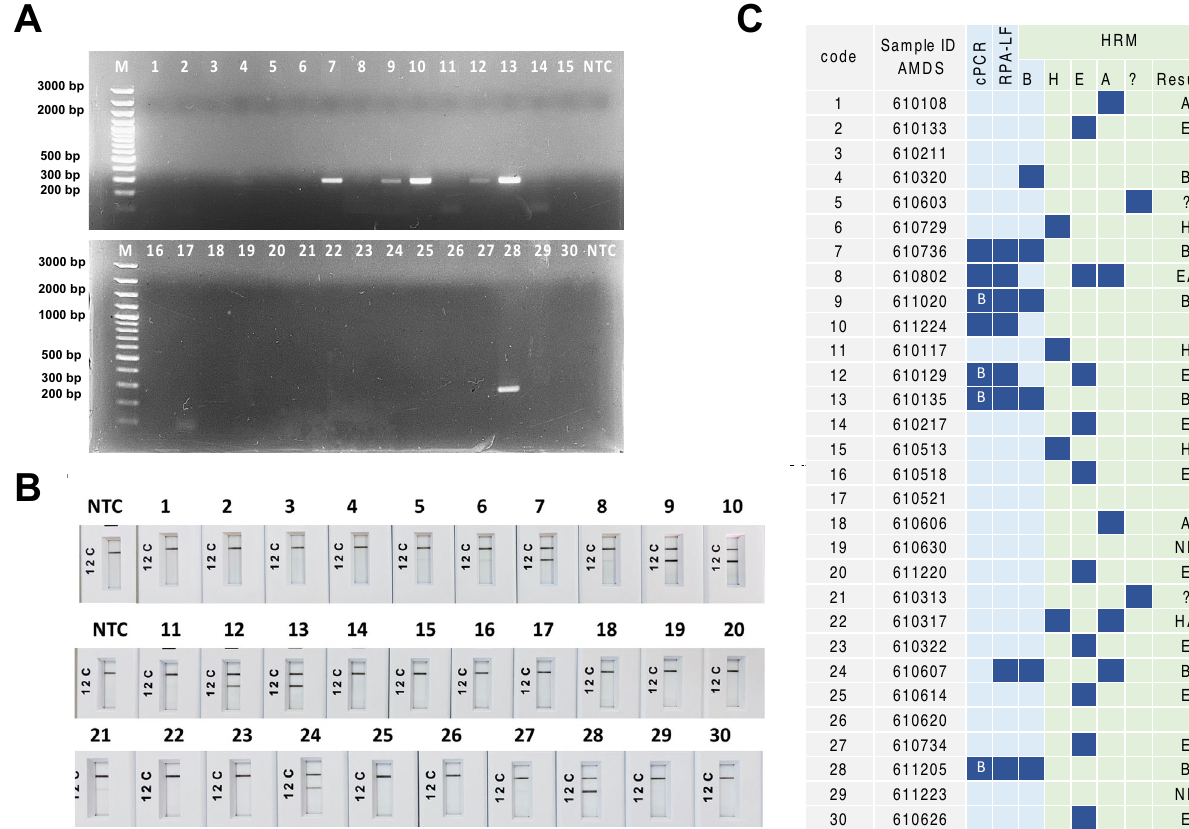
Figure 6. Performance of RPA-LFD using rpaBab264 assay on clinical samples from canine blood compared to cPCR and mHRM. Results were obtained from cPCR ( A ) and RPA-LFD ( B ). Non-template control is abbreviated as NTC. Diagnostic results of three approaches including cPCR, RPA-LFD and mHRM are represented ( C ). mHRM results of 30 clinical samples are illustrated in Supplemental files 2 and 4. Letter “B” in the cPCR results represents sequence results of PCR products matching B. vogeli . The symbol “?” represents an unknown peak from mHRM, resulting in an unidentified species. Not detectable (ND) refers to samples with no amplification signal from mHRM. Sequences of codes 9, 12, 13 and 28 were deposited in GenBank as accession numbers OP602997–OP603000,